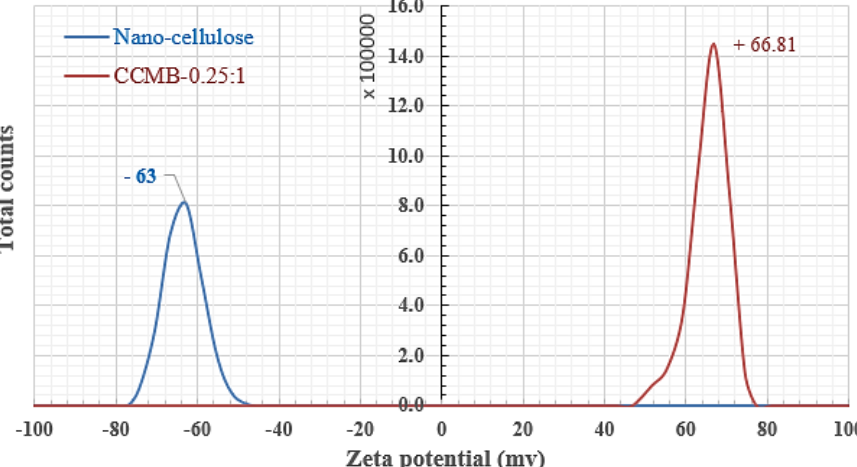
Figure 14. Zeta potential analysis of nanocellulose and nanocellulose/chitosan microbead (CCMB- 0.25:1).